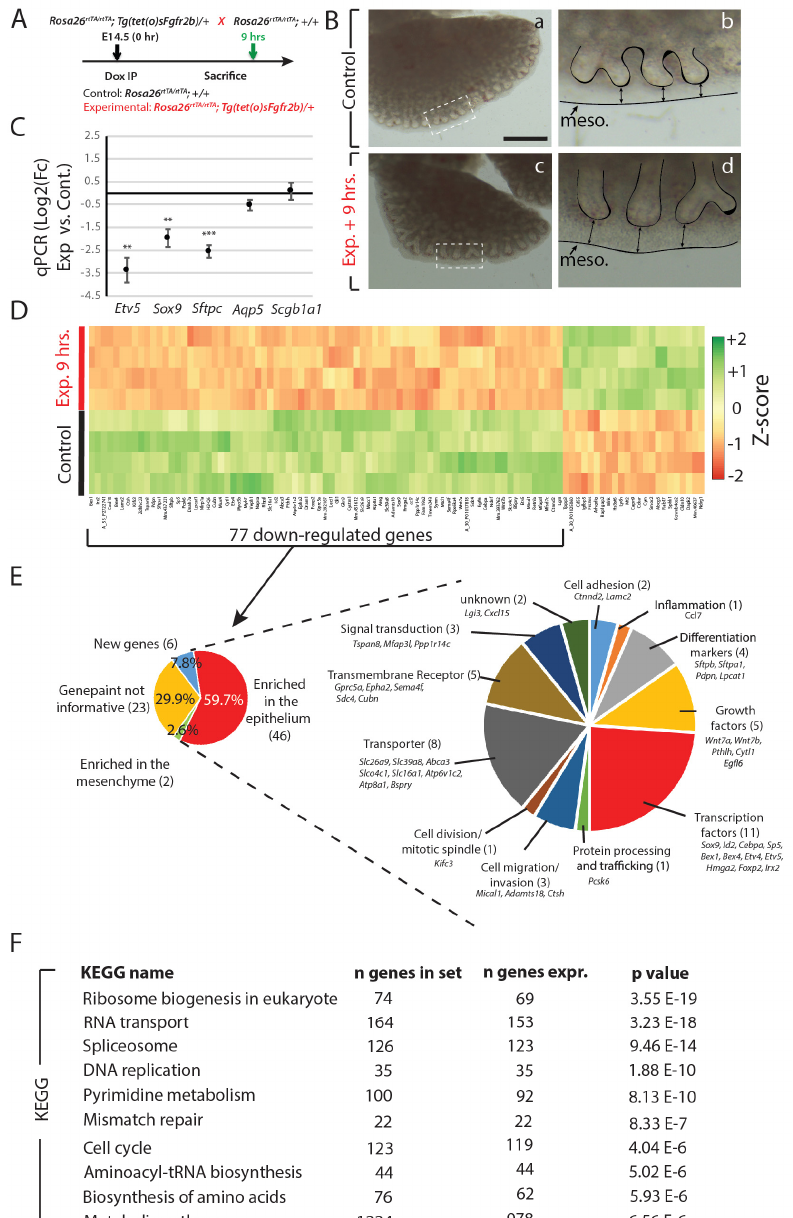
Figure 1. Transcriptomic e ff ects of transient Fgfr2b signaling inhibition for 9 h in E14.5 lungs. ( A ) Experimental design: pregnant females carrying E14.5 experimental and littermate control embryos were injected with a single Dox-IP and sacrificed 9 h later. ( B ) Brightfield images of control (a,b) and experimental (c,d) lungs. Note the elongated epithelial tubes, reduced branching, and increased distance between the distal tips and mesothelium (black arrows) in the experimental lung compared to control. (Meso. = mesothelium). Scale bar: (a,c) 500 µ m, (b,d) 125 µ m. ( C ) qPCR analysis showing downregulation of Etv5 , Sox9 , and Sftpc in experimental vs. control lungs, while little change is observed in Aqp5 and Scgb1a1 . ( n = 3; ** p -value < 0.01, *** p -value < 0.001). ( D ) Microarray expression data of the top 100 genes (according to the p -value) regulated in experimental vs. control lungs. ( E ) Gene ontology of the 77 downregulated genes from the heatmap in D. Genes were first grouped based on their region of enrichment in the lung according to expression data from ‘genepaint’. The 46 genes enriched in the epithelium, and thus considered to be direct targets of Fgfr2b signaling, were then grouped according to their primary biological functions. ( F ) KEGG pathway analyses of the entire microarray data showing the top 10 regulated pathways in the experiment, according to